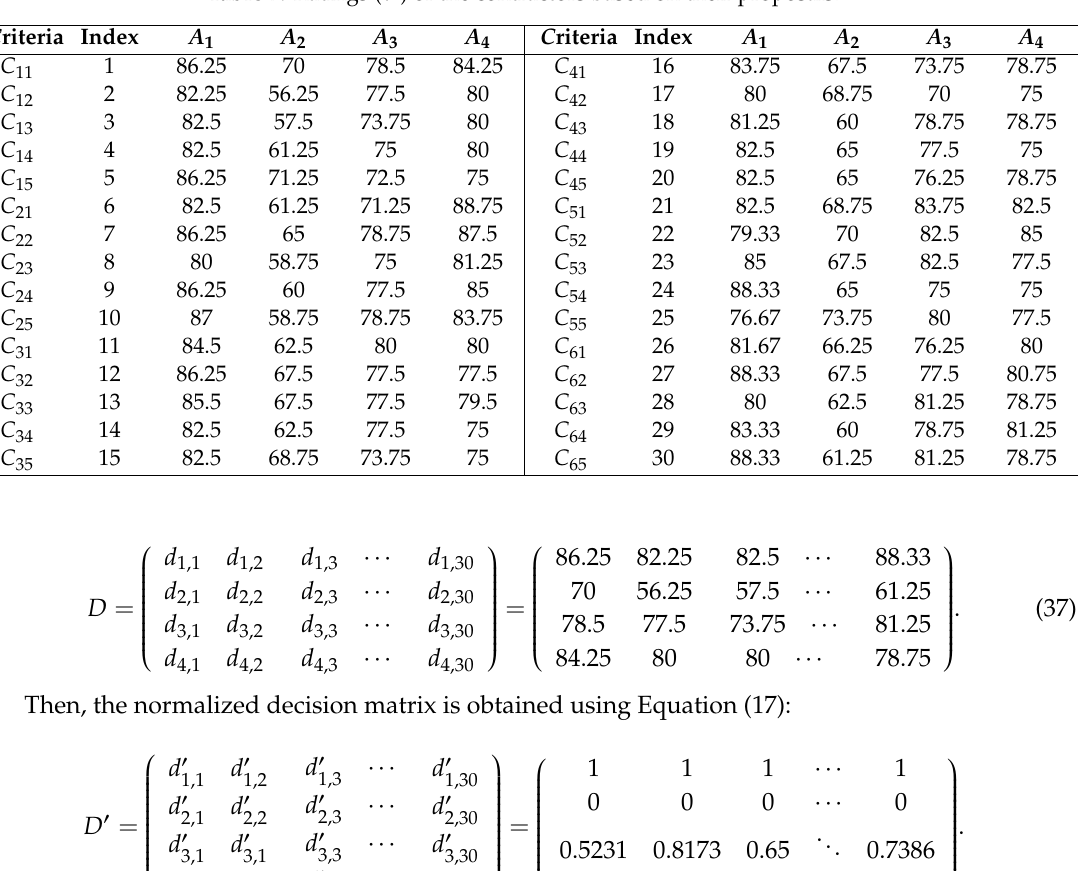
Table 7. Ratings (%) of the contractors based on their